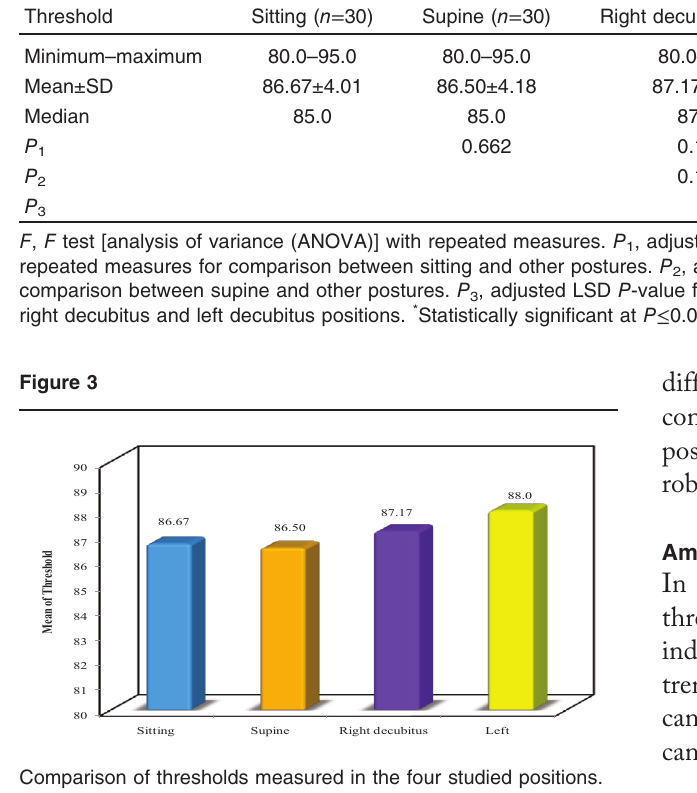
Comparison of thresholds measured in the four studied